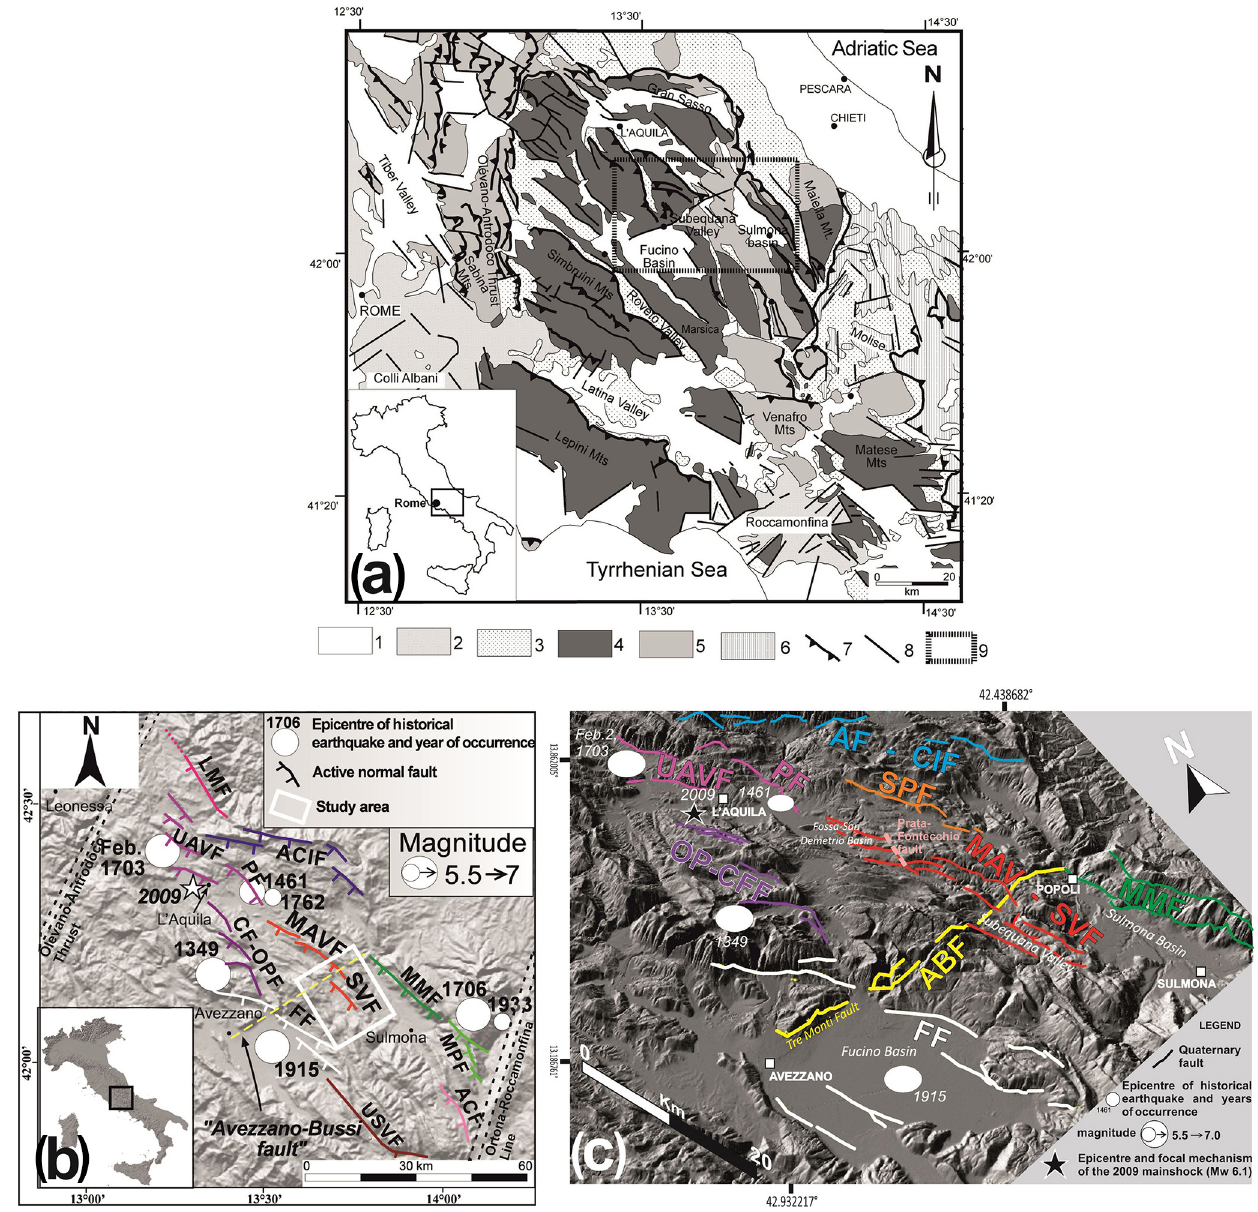
Figure 1. (a) Geological–structural scheme of the central Apennines. (1) Marine and continental clastic deposits (Pliocene–Quaternary); (2) volcanic deposits (Pleistocene); (3) synorogenic hemipelagic and turbiditic sequences (Tortonian–Pliocene); (4) carbonate platform deposits (Triassic–Miocene); (5) slope and pelagic deposits (Lias–Miocene); (6) Molise–Sannio pelagic deposits (Cretaceous–Miocene); (7) main thrust fault; (8) main normal and/or strike–slip fault; (9) study area. (b) Seismotectonic framework of the central Apennines (shaded relief); faults (colours indicate splays and segments comprised in the same fault system): MAV-SVF, Middle Aterno Valley–Subequana Val- ley fault system; ABF, Avezzano–Bussi fault; FF, Fucino fault; MMF, Mt Morrone fault; OP-CFF, Ovindoli–Pezza–Campo Felice fault, SPF, San Pio fault; AF-CIF, Assergi–Campo Imperatore fault system; UAVF, Upper Aterno Valley fault system; PF, Paganica fault. (c) Shaded relief in perspective view of the seismotectonic setting of the area under